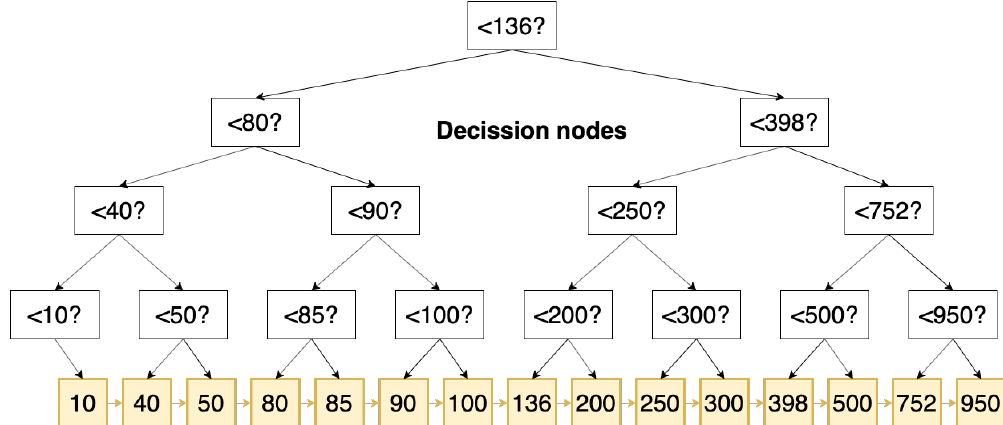
Figure 4. Index B+ tree organization. (Orange nodes) Nodes with a pointer to a row in the associated table they also have a link to their successor in the B+ tree, (White nodes) They are the decision